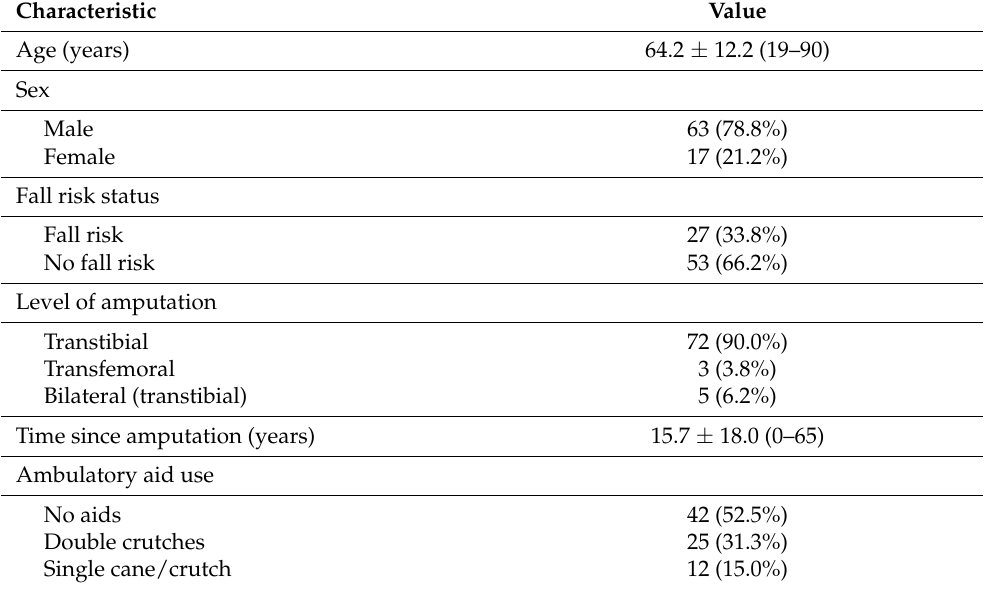
Table 1. Participant